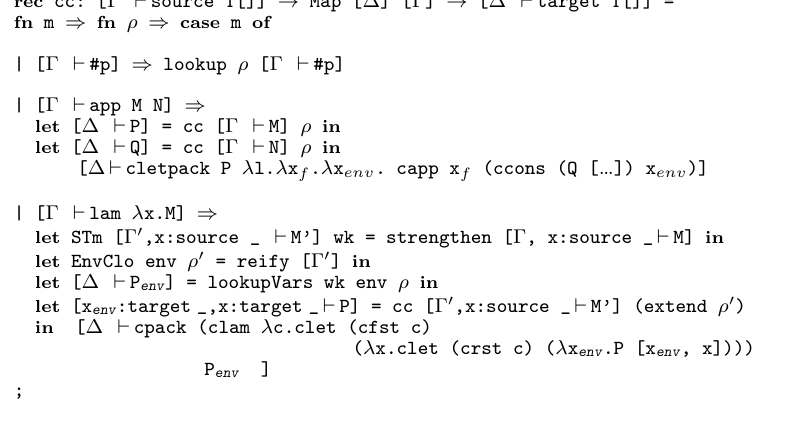
Fig. 13. Implementation of Closure Conversion in